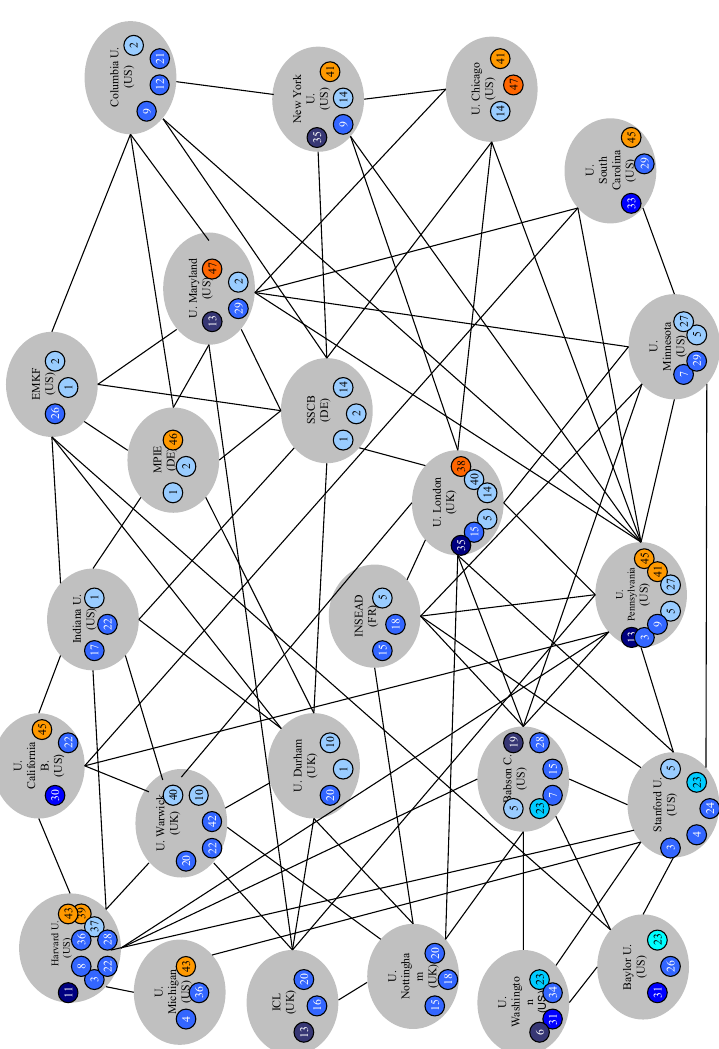
Fig. 2 . Mapping links among top cited authors in entrepreneurship scientific area Note : Each link means that at least one top cited author worked in the two linked